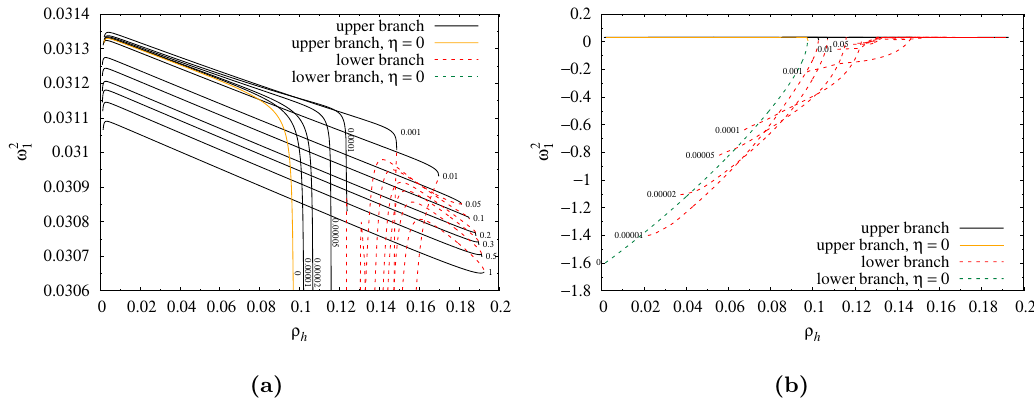
Figure 18 . The lowest eigenvalue, ! 2 , of the linear perturbation of the pro(cid:12)le function, f 0 , in the 1 2 + 4 + 12 model with (cid:17) ! 0. The numbers on the (cid:12)gures indicate the di(cid:11)erent values of (cid:17) = 0, 10 (cid:0) 5 , 2 (cid:2) 10 (cid:0) 5 , 5 (cid:2) 10 (cid:0) 5 , 10 (cid:0) 4 , 0 : 001, 0 : 01, 0 : 05, 0 : 1, 0 : 2, 0 : 3, 0 : 5, 1. The upper and lower (cid:17) = 0 branches are shown in orange and dark green colors,